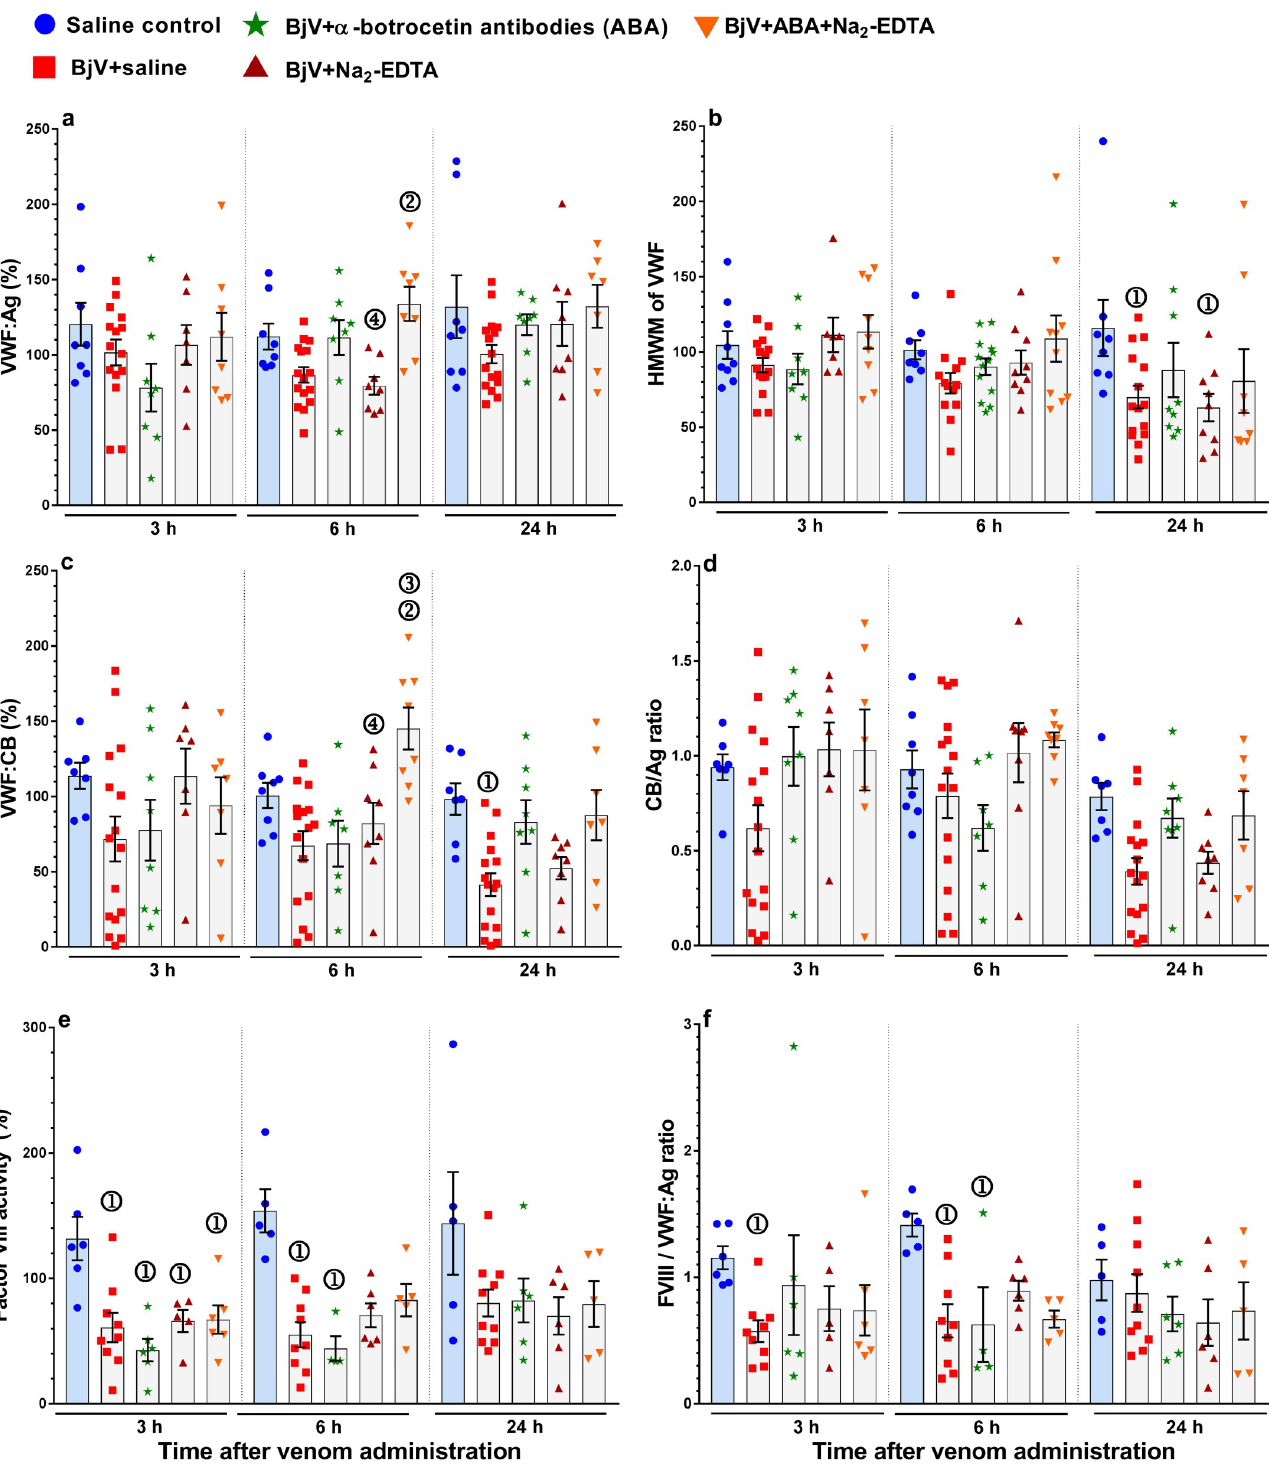
Fig 3. Circulating levels of parameters of VWF and factor VIII function in rats 3, 6 and 24 h after BjV administration. VWF antigen (VWF:Ag, a ), high molecular weight multimers of VWF (HMWM of VSF, b ), collagen-binding activity (VWF:CB, c ), the VWF:Ag/VWF:CB ratio ( d ), factor VIII activity ( e ), and the factor VVIII/VWF:Ag ratio (FVIII/VWF:Ag ratio, f ). Rats were injected with saline alone (saline control, blue bars), or BjV previously incubated with saline (BjV +saline), anti-botrocetin antibodies (ABA), BjV+Na 2 -EDTA, or BjV+ABA+Na 2 -EDTA. ① —Group statistically different (p < 0.05) from the saline control group at the respective time. ② - Group statistically different (p < 0.05) from the BjV+saline group at the respective time. ③ —Group statistically different (p <